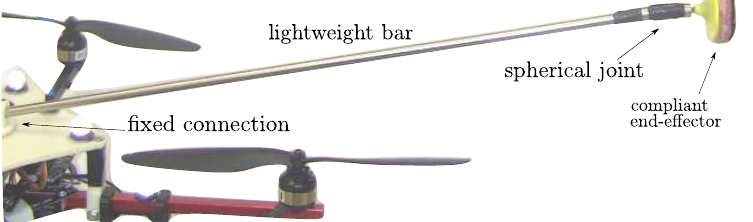
Figure 2. The passive lightweight tool with compliant end-effector used to convert a normal VTOL UAV to an aerial